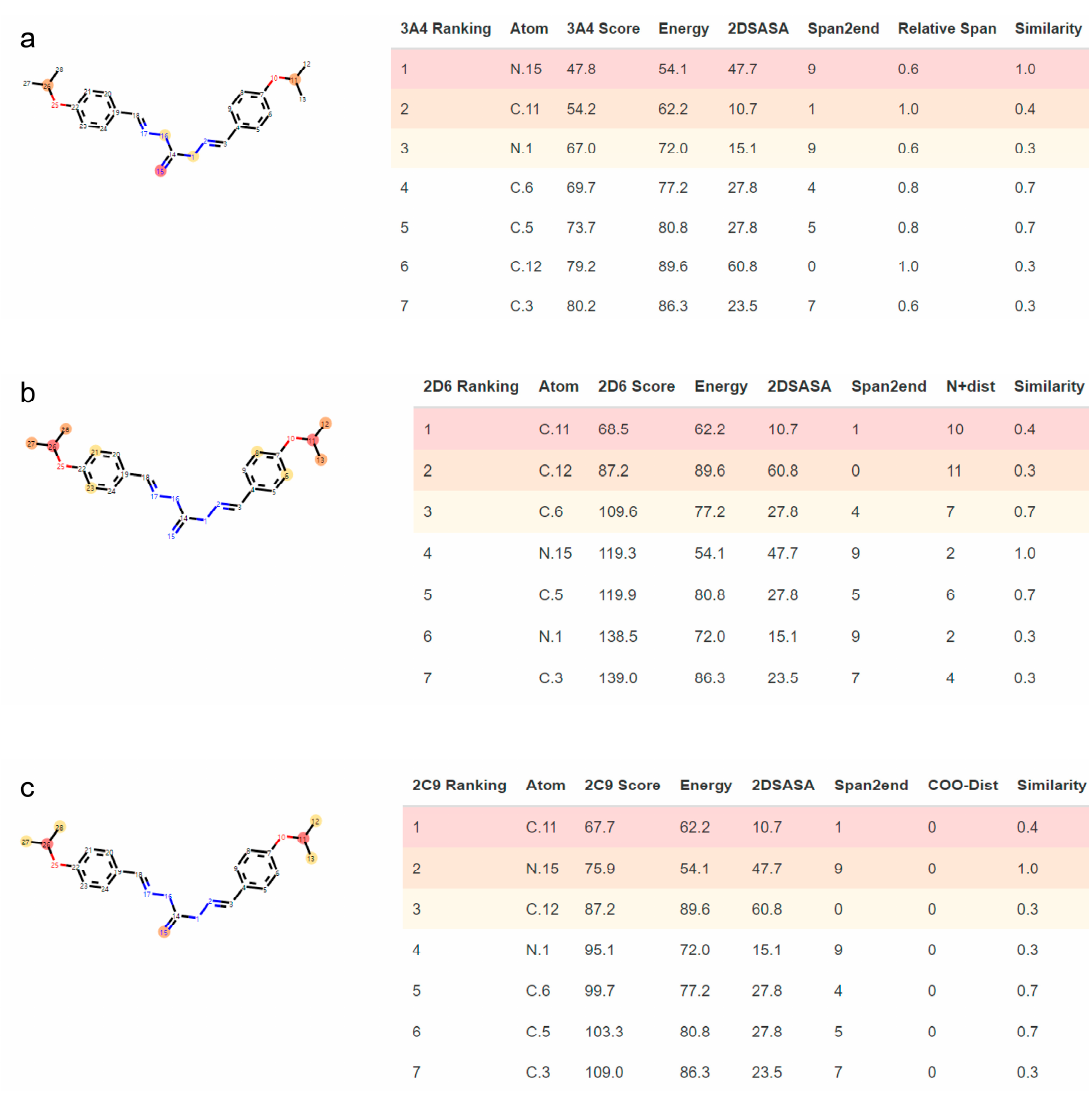
Figure 1. Metabolic site prediction using SMARTCyp web server by CYP3A4 ( a ), CYP2D6 ( b ), and CYP2C9 ( c ) for IBG.